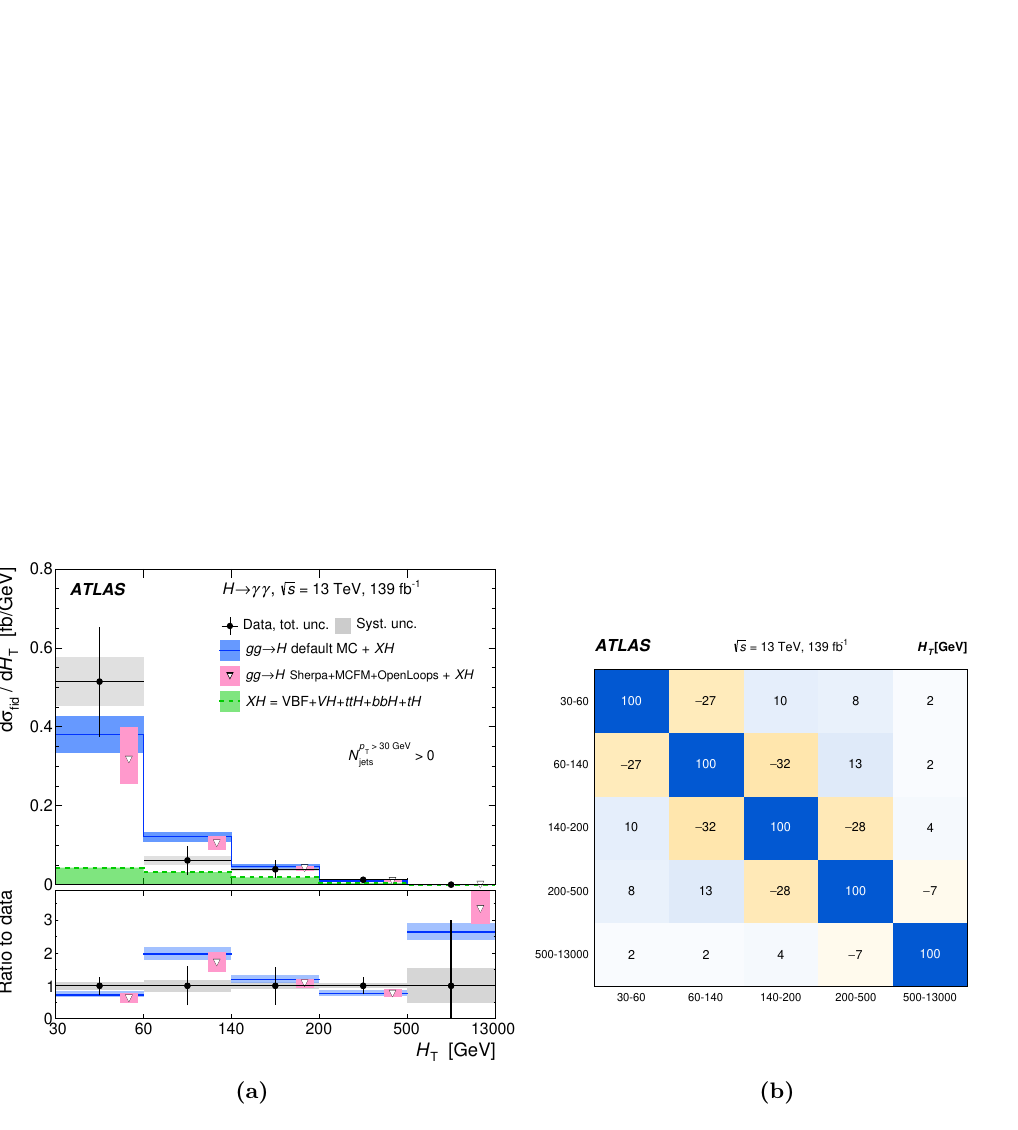
Figure 28. Particle-level fiducial differential cross-sections times branching ratio for (a) H T together with the corresponding correlation matrix